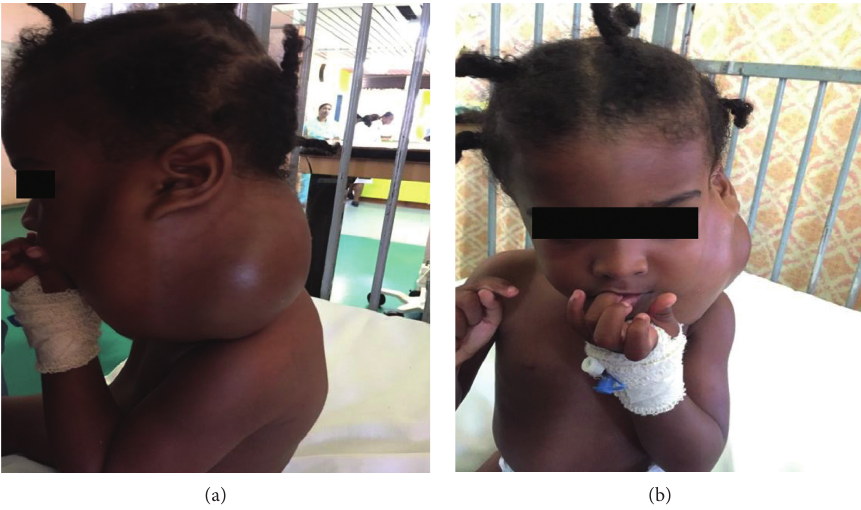
Figure 1: Preoperative clinical photos of left cervical cystic hygroma.